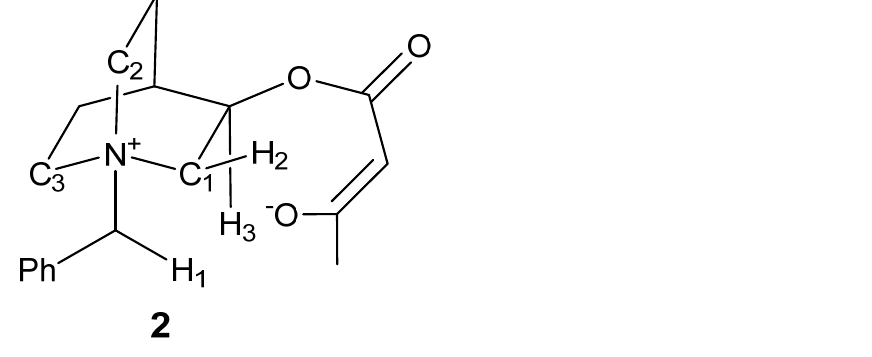
Figure 6. Selected 1 H and 13 C NMR signals for 2 assigned via HMBC and HSQC.